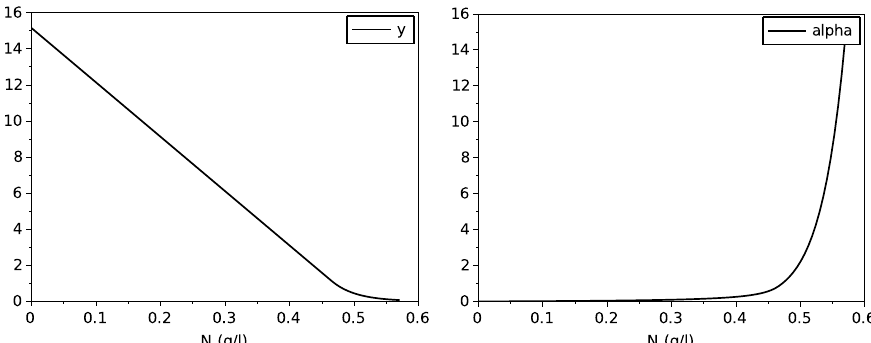
Figure 12. Graphs of the obtained variable yield function y and of the function α .